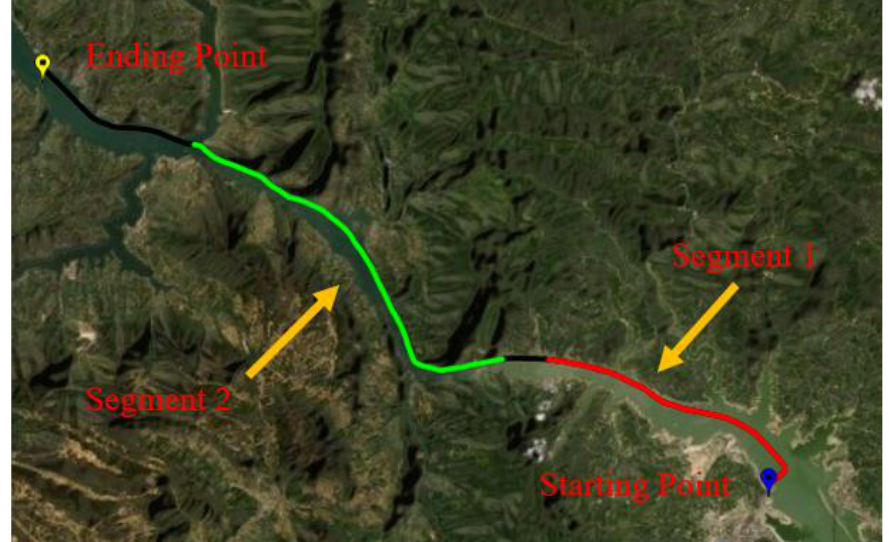
Figure 10. The trajectory of experiment.